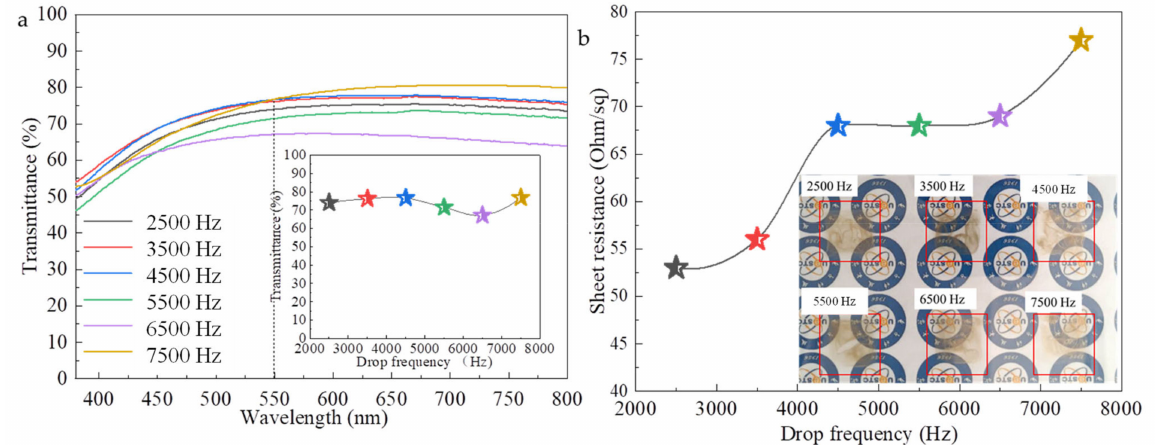
Figure 9. Transmittance ( a ) and sheet resistance ( b ) of the AgNWs films with different drop frequencies. The insert has transmittance at 550 nm in ( a ) and photographs of samples in ( b